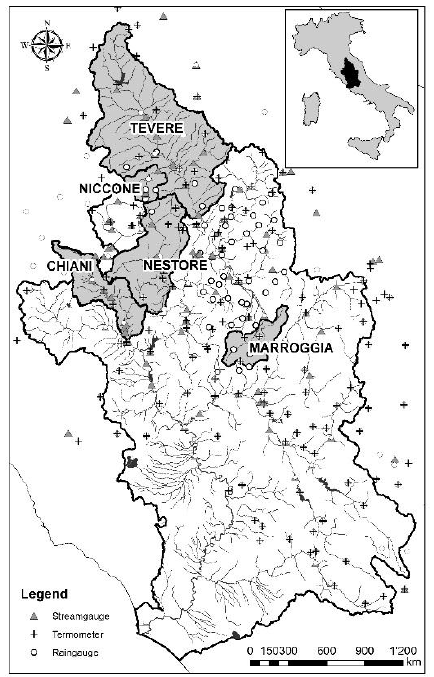
Figure 1. Study area, catchment locations and hydro-meteorological